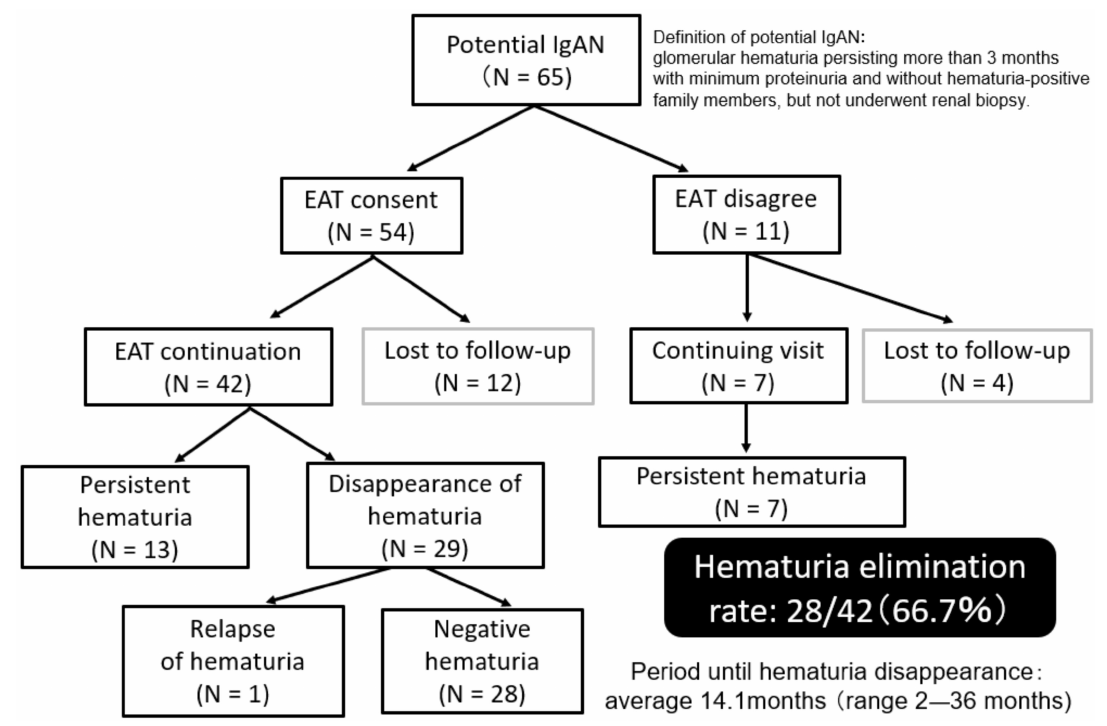
Figure 13. Effects of epipharyngeal abrasive therapy on hematuria in potential